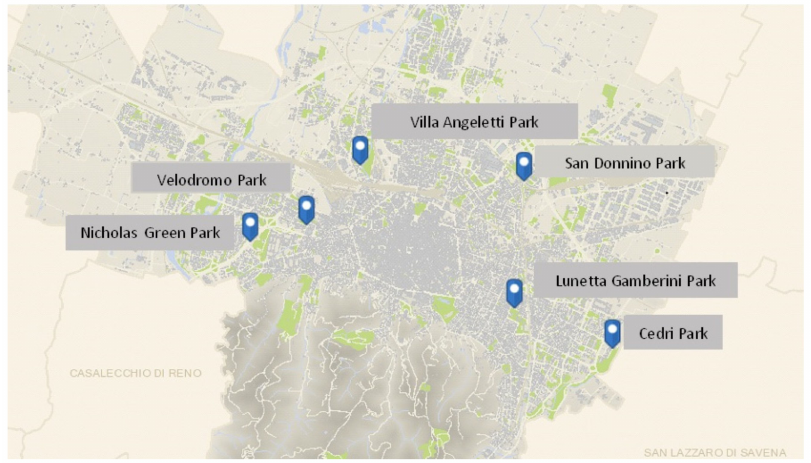
Figure A1. Map of Bologna, with highlighted the six parks considered. The six parks are in different neighborhoods of Bologna and have different character- istics, listed